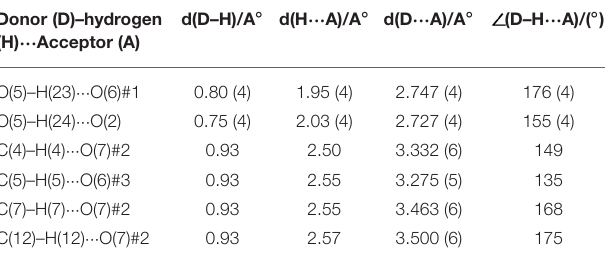
TABLE 2 | Hydrogen bond parameters (Å, ◦ ) in the supramolecular architecture of compound 1 a .